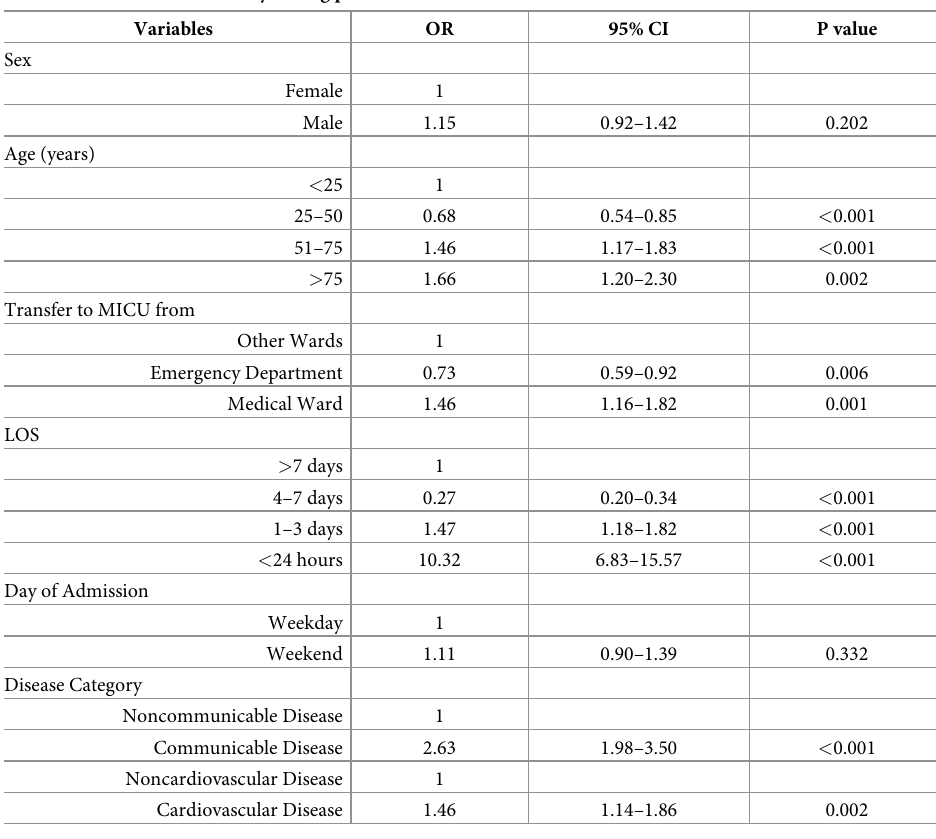
Table 3. Predictors of mortality among patients admitted to